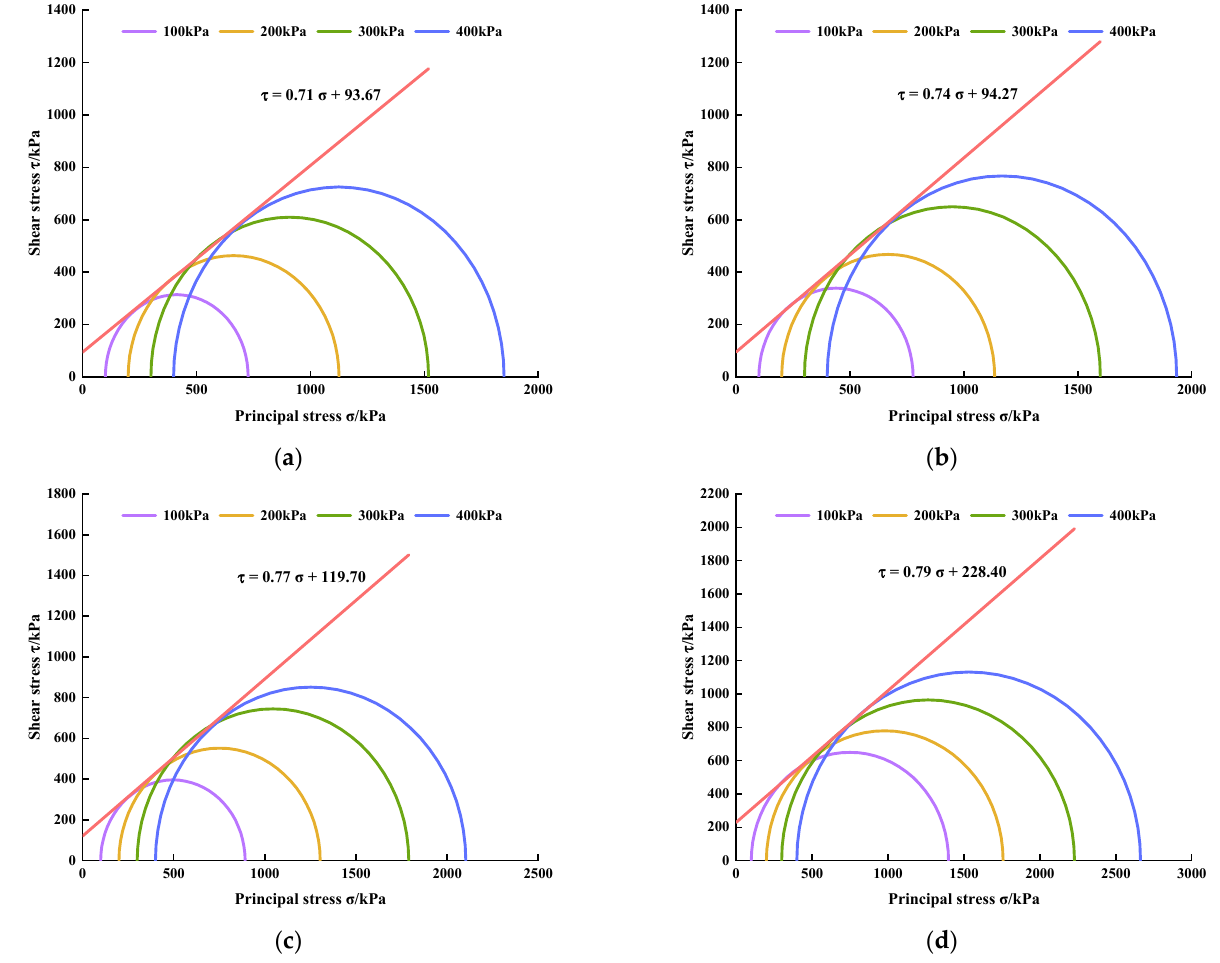
Figure 9. Limit Mohr stress circles and shear strength envelopes of PURD at 7 days of curing time. ( a ) PURD-3; ( b ) PURD-4; ( c ) PURD-5; ( d ) PURD-6. Under the same WPU content, the internal friction angle and cohesion of PURD both increase with curing time, but not obviously. The strength of PURD is mainly provided by the bite force and friction generated by the mutual extrusion of RA particles and the bonding force generated by the curing reaction of WPU. The increase in internal friction is mainly due to the curing reaction between WPU and water in the specimen, and the curing reaction will gradually end with the increase in curing time, resulting in the decrease in water in the specimen. The internal friction angle will increase with the decrease in water content, and the decrease in water content will lead to the increase in bite force and friction between RA particles [50]. Additionally, WPU itself is also prone to oxidative consolidation reaction, which will produce high-strength adhesion and can better bond loose RA particles together. Moreover, a large number of long-chain macromolecules and isocyanate groups in WPU make it have a special polymer reticular structure, which can significantly improve the cohesion of the specimen [31,32]. With the increase in curing time, the consolidation reaction between WPU and water and the oxidative consolidation reaction of WPU will proceed more completely, thereby further increasing the cohesion of